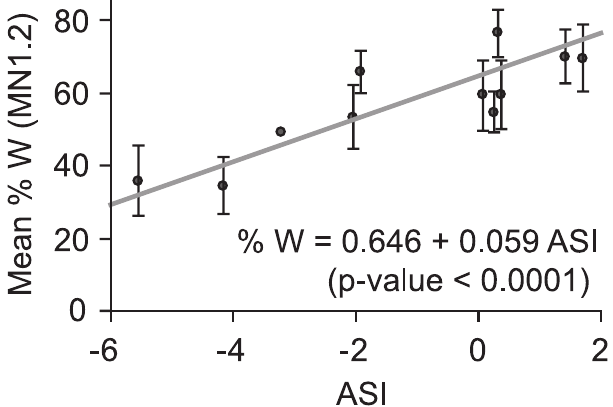
Figure 5. Relationship between Marker Genotype at MN1.2 and ASI in the CWW F 2 Population For each ASI value, the mean percentage of Wa-1 allele (gray dots) and corresponding standard errors (bars) are presented. No standard error could be calculated for classes containing only one individual. A regression curve was calculated using each individual independently, and the regression was significant ( p -value , 0.0001, R 2 ¼ 0.16).